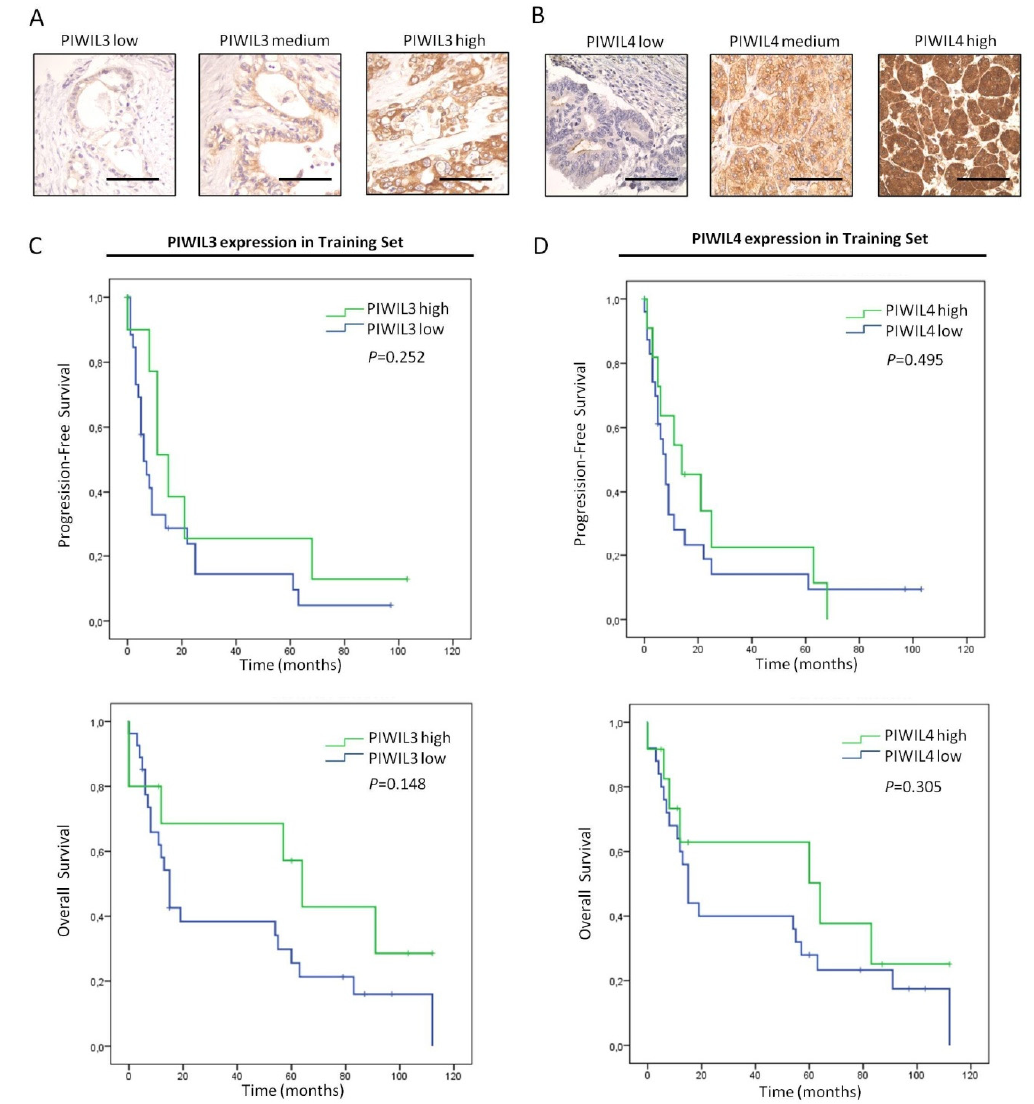
Figure 5. Prognostic impact of PIWIL3 or PIWIL4 in PC patients from the training set. ( A ) Representative micrographs of tumors with low (left), intermediate (middle) and high PIWIL3 expression (right). ( B ) Representative micrographs of tumors with low (left), intermediate (middle) and high PIWIL4 expression levels (right). ( C ) Kaplan–Meier curves according to PIWIL3 protein expression for both progression-free (top) and overall survival (bottom). ( D ) Kaplan–Meier curves according to PIWIL4 protein expression for both progression-free (top) and overall survival (bottom). p -values were obtained by log-rank test. Scale bars: 50 µm.